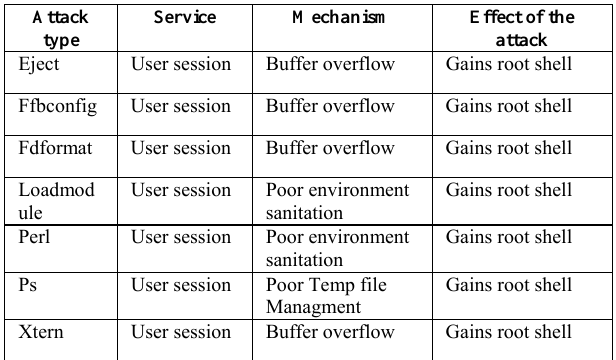
Table 3. User to root attack (U2R)